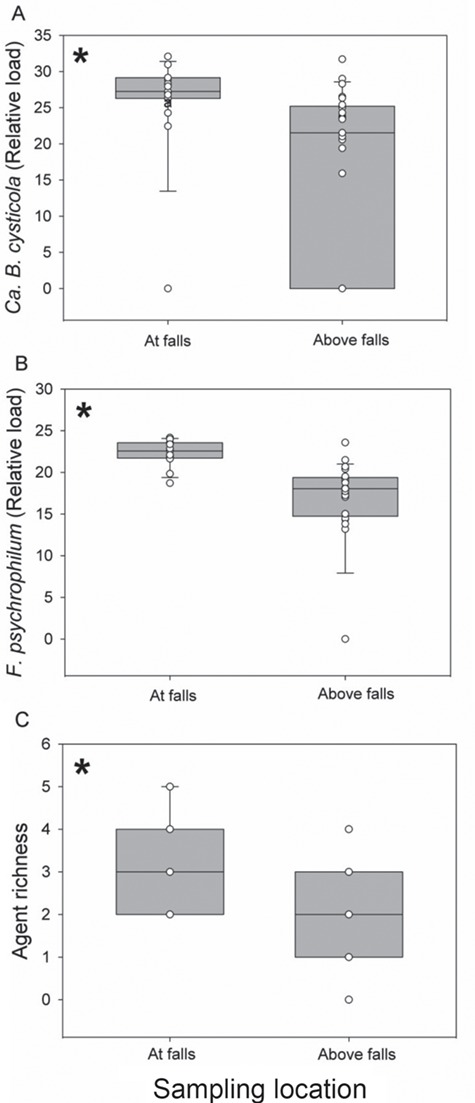
Boxplots depicting the relative load of (A) Ca. B. cysticola (B) F. psychrophilum and (C) agent richness in the gill tissue of steelhead sampled above the falls and at the falls. Asterisks denote a statistically significant difference (P < 0.05).